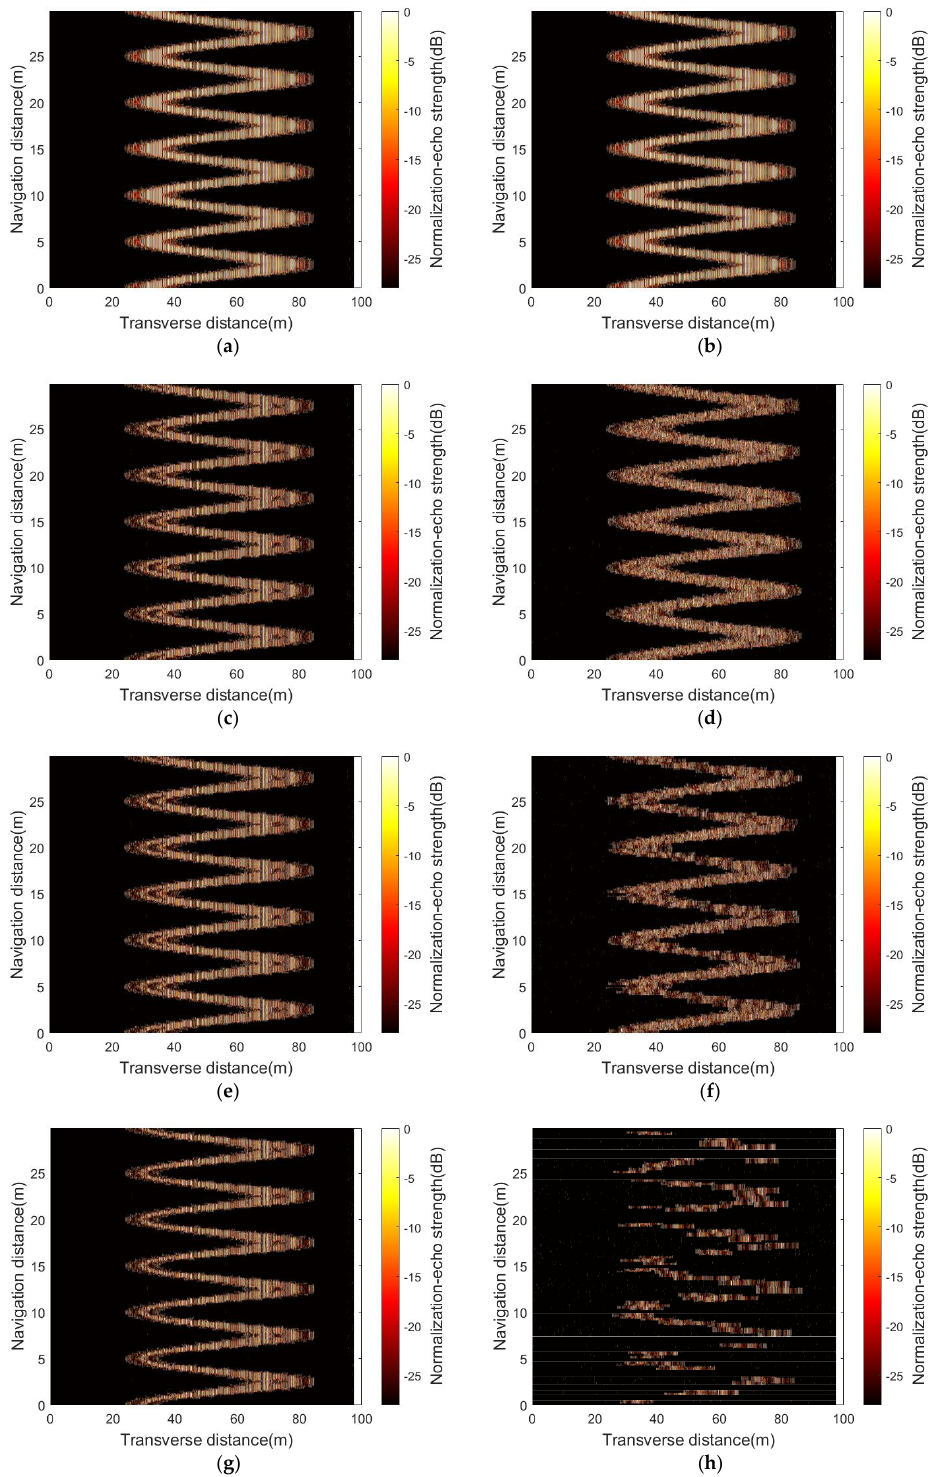
Figure 16. Simulation imaging results using single–beam side–scan sonar using LFM signal as center frequency 400 kHz, bandwidth 30 kHz, and pulse width 5 ms, where ( c , e , g ) are simplified by the new energy function and ( d , f , h ) are simplified by the conventional energy function: ( a ) is the simulation image of the original model; ( b ) is simplified to 5125 data points using the new energy function; ( c , d ) are simplified to 3000 data points; ( e , f ) are simplified to 1000 data points; ( g , h ) are simplified to 176 data